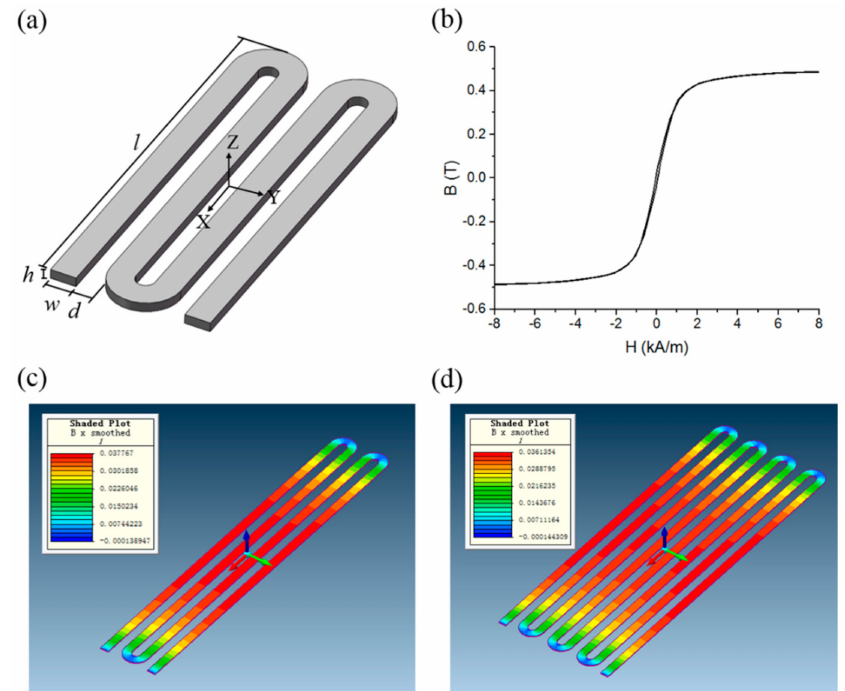
Figure 1. ( a ) Schematic view of the meander-core structure. ( b ) B - H curve of the Co-based amorphous ribbon used in the simulation. Magnet simulation results of magnetic flux density distribution of meander-core with: ( c ) four and ( d ) eight strips in x-direction (the length and line width of strips is 8 mm and 200 µ m, respectively, the spacing between all the strips is 150 µ m, and H 0 = 100 µ T, applied in the x-axis).